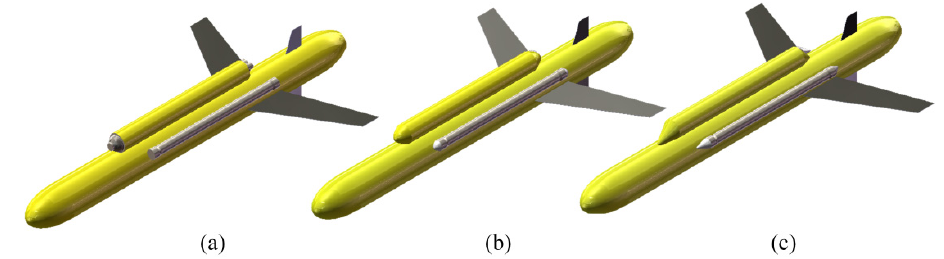
Figure 4. Three types of fairings for the thermal energy power generation module ( a ) flat fairing; ( b ) conical fairing; ( c ) inclined conical fairing.